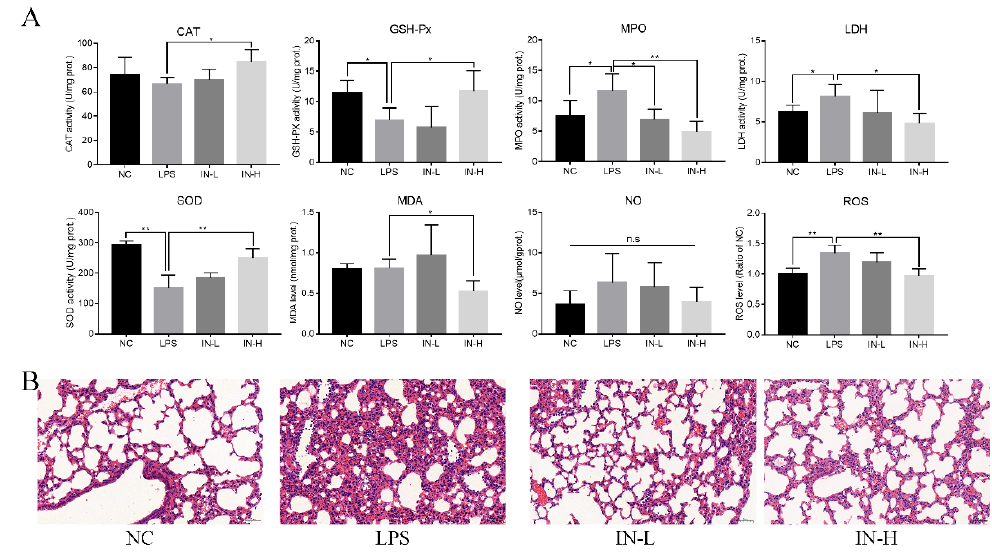
Figure 3. Effects of inosine pretreatment on the levels of CAT, GSH-Px, SOD, MPO, LDH, MDA, NO, and ROS in mice treated with LPS ( A ); histological examination of lung tissue by hematoxylin–eosin staining ( B ). * p < 0.05; ** p < 0.01, relative to the LPS group, n.s.: not significant.